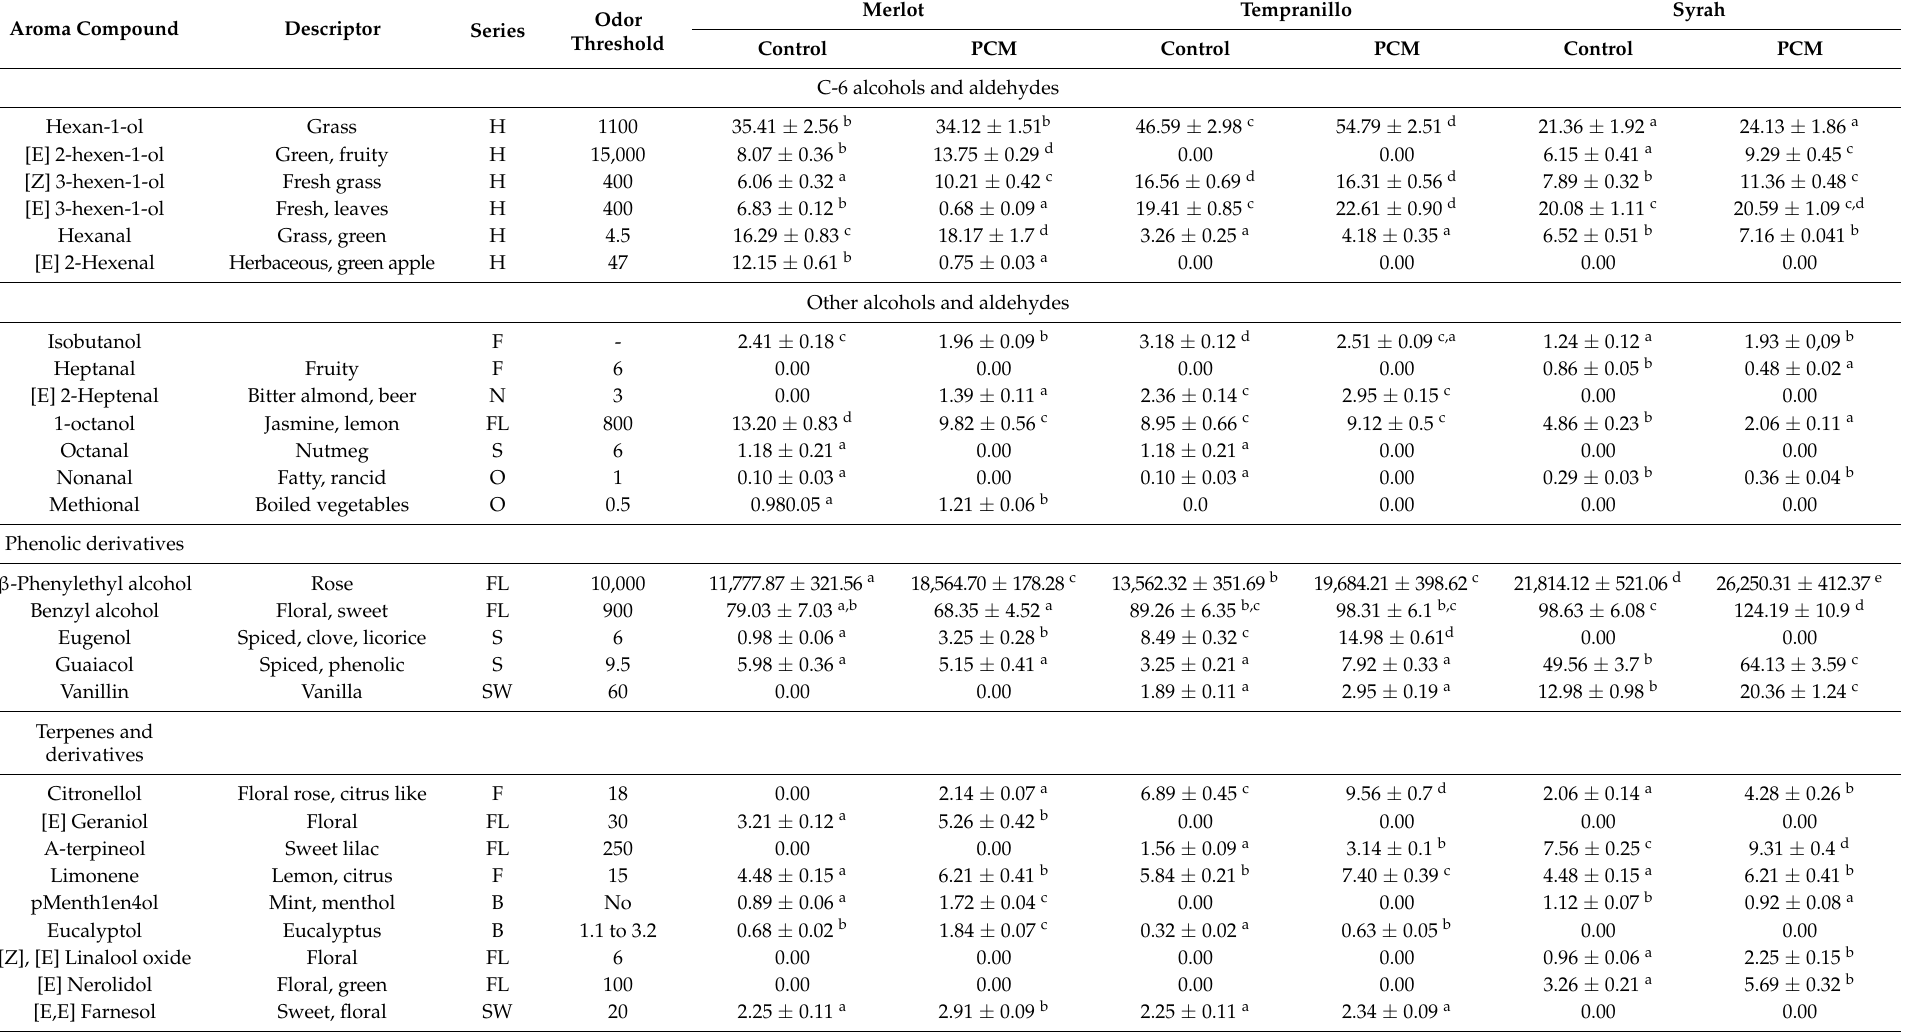
Table 3. The aromatic composition of the wines. Values in µ